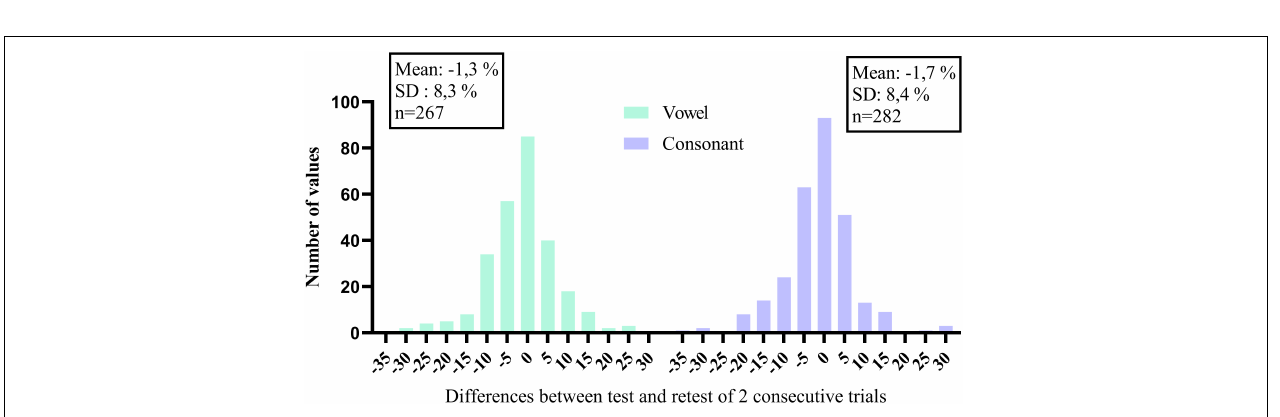
FIGURE 4 | Histograms of the differences in percentage correct of consecutive trials, for vowels and consonants separately.